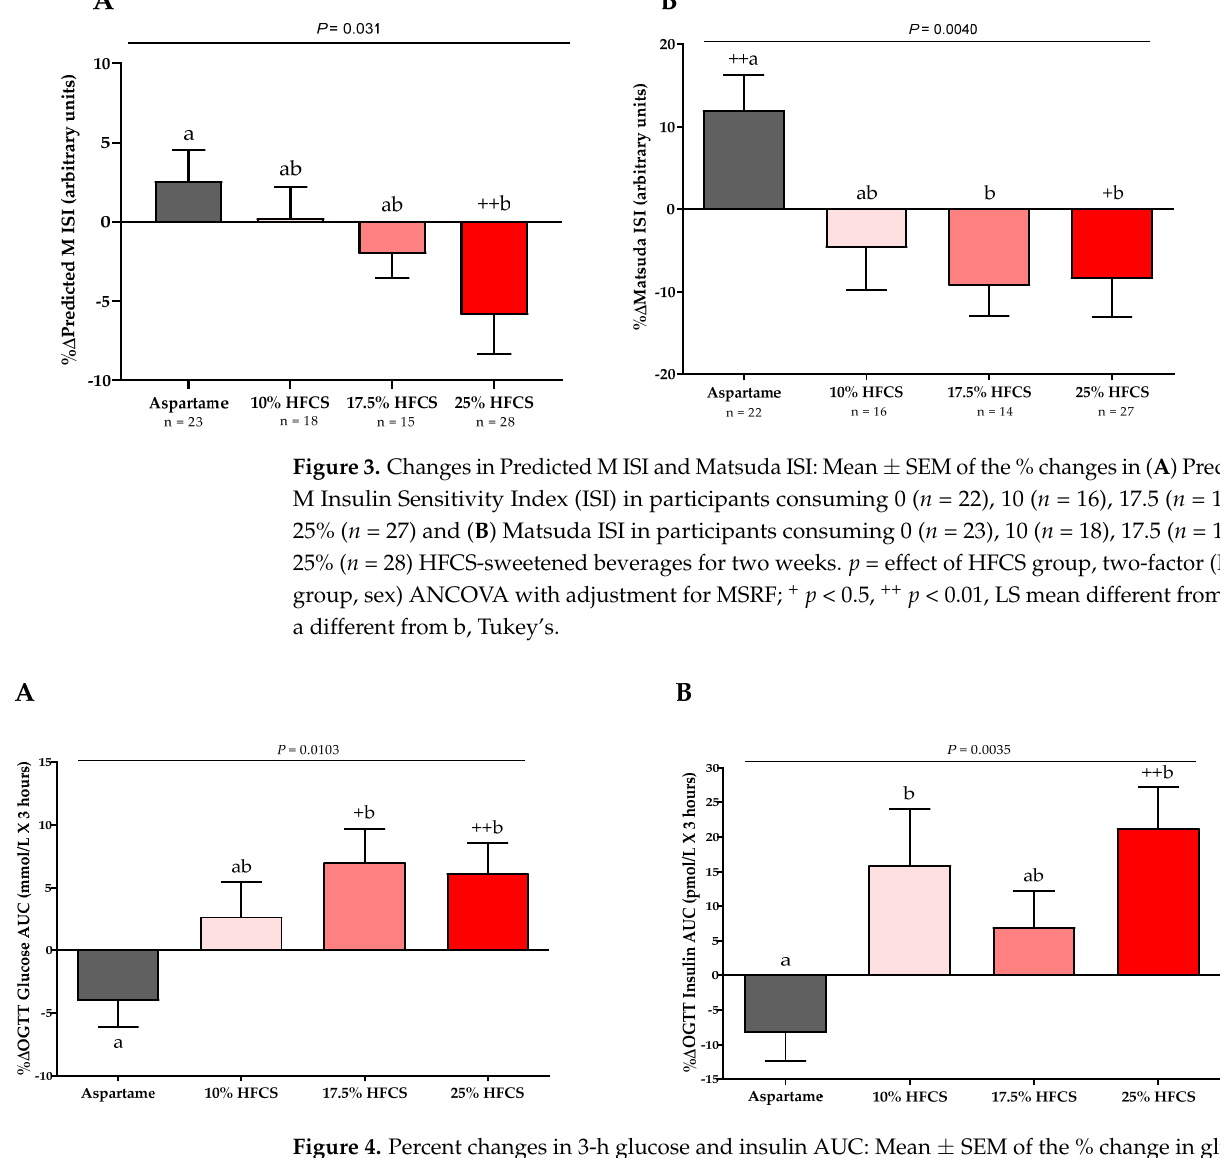
Figure 4. Percent changes in 3-h glucose and insulin AUC: Mean ± SEM of the % change in glucose ( A ) and insulin ( B ) AUC during OGTT in participants consuming 0 ( n = 23), 10 ( n = 18), 17.5 ( n = 15), or 25% ( n = 28) HFCS-sweetened beverages for the two-week intervention. p = effect of HFCS group, two-factor (HFCS group, sex) ANCOVA with adjustment for MSRF; + p < 0.05, ++ p < 0.01, LS mean different from zero; a different from b, Tukey’s.